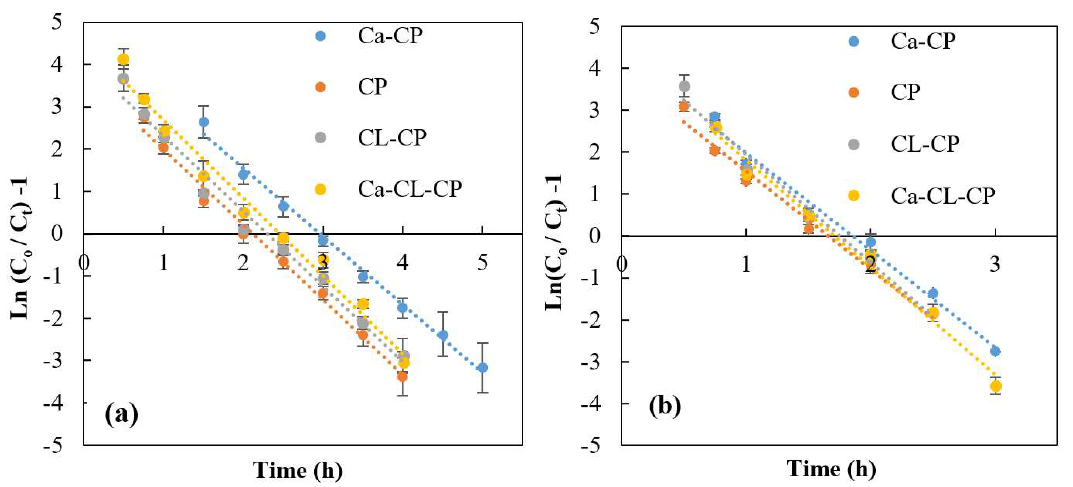
Figure 5. Linear plots of Thomas model for various adsorbents at 25 °C: (a) pH 4.5, and (b) pH 6.5, at an initial sulfate concentration = 1000 mg/L, flow rate of 3 mL/min, and bed depth of 200 mm.